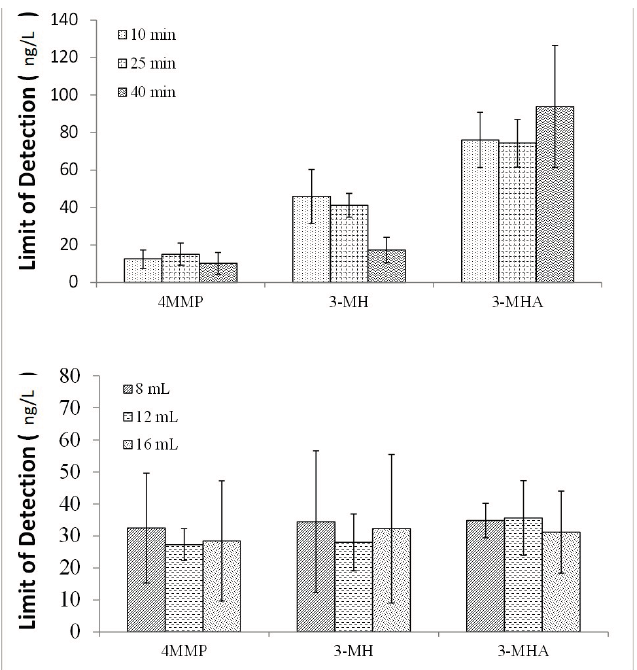
Figure A2. Effects of agitation time ( top ) and volume of organic solvent ( bottom ) on detection limits obtained for each thiol. Error bars represent ± 1 standard deviation for 3